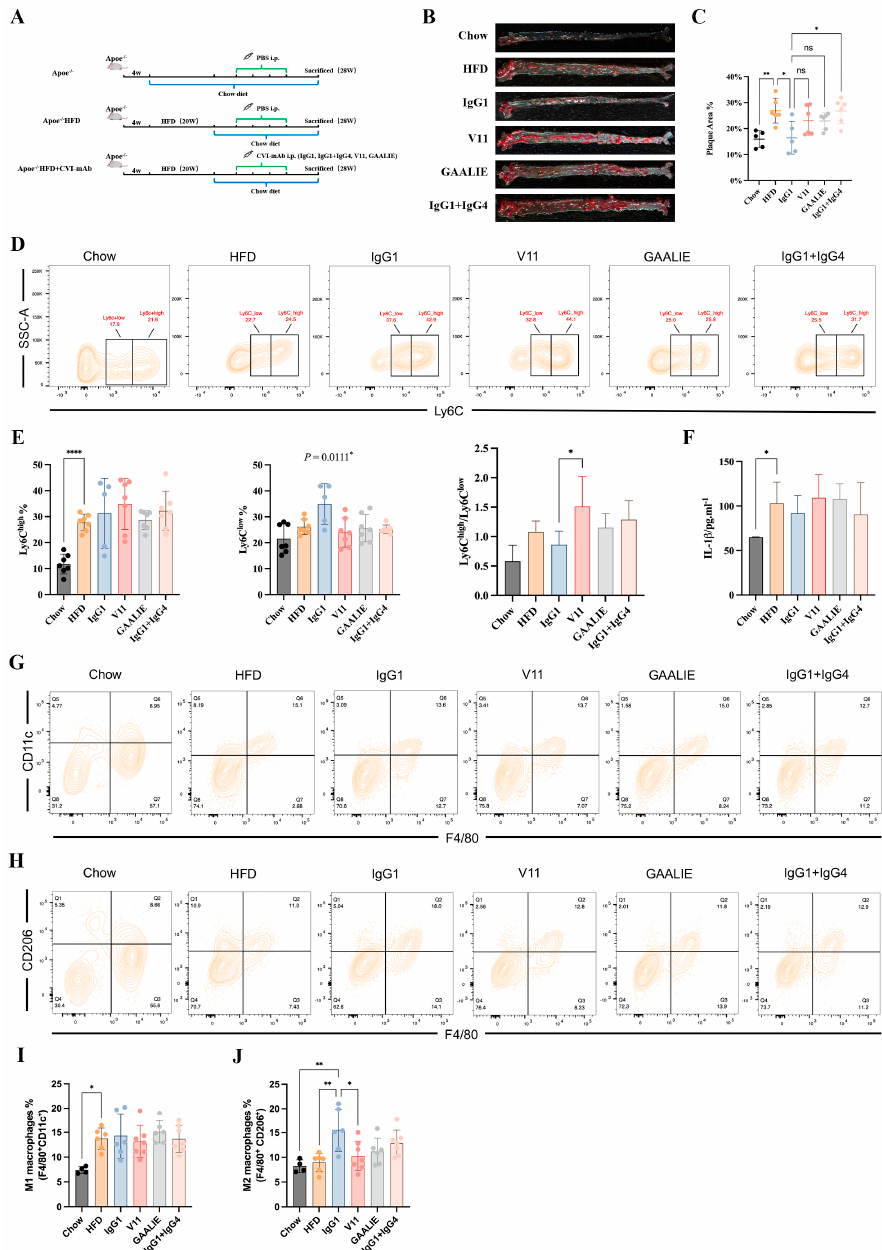
Figure 8. CVI-IgG1 reduced atherosclerotic plaque area in Apoe -/- mice. ( A ) High-fat diet-induced mouse model experimental protocol and antibody therapy strategy. ( B ) Aortic Oil red O staining in different groups. ( C ) Percentage of plaque area of the entire artery (Chow: n = 5, HFD: n = 6, IgG1: n = 5, V11: n = 6, GAALIE: n = 6, IgG1/IgG4: n = 6). ( D ) Flow cytometry analysis of different groups of monocyte (Chow: n = 7, HFD: n = 7, IgG1: n = 5, V11: n = 7, GAALIE: n = 7, IgG1/IgG4: n = 7). ( E ) Percentage of monocytes (Ly6C high and Ly6C low ) in different groups and ratio of Ly6C high /Ly6C low in different groups. ( F ) Measurement of serum IL-1 β levels by ELISA (Chow: n = 6, HFD: n = 7, IgG1: n = 5, V11: n = 7, GAALIE: n = 7, IgG1/IgG4: n = 7). ( G , H ) Flow cytometry analysis of different groups of intraperitoneal M1 and M2 macrophages (Chow: n = 4, HFD: n = 6, IgG1: n = 6, V11: n = 7, GAALIE: n = 7, IgG1/IgG4: n = 7). ( I , J ) Percentage of M1 (F4/80 + CD11c + ) and M2 (F4/80 + CD206 + ) macrophages in different groups. Data are expressed as mean ± SD. One-way ANOVA followed by Tukey’s multiple comparisons test, * p < 0.05, ** p < 0.01, **** p <